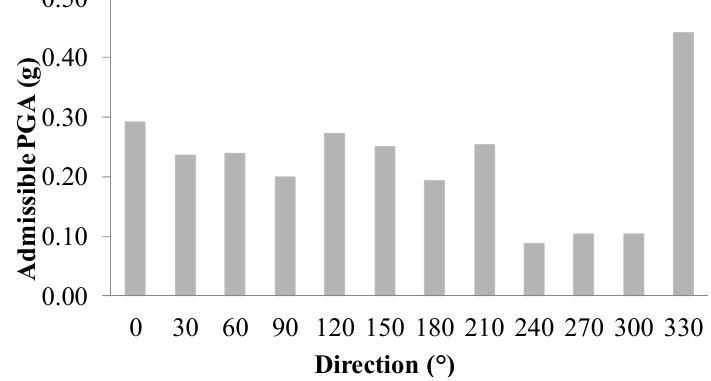
Figure 21. Assessment of the admissible PGA along all the investigated directions.